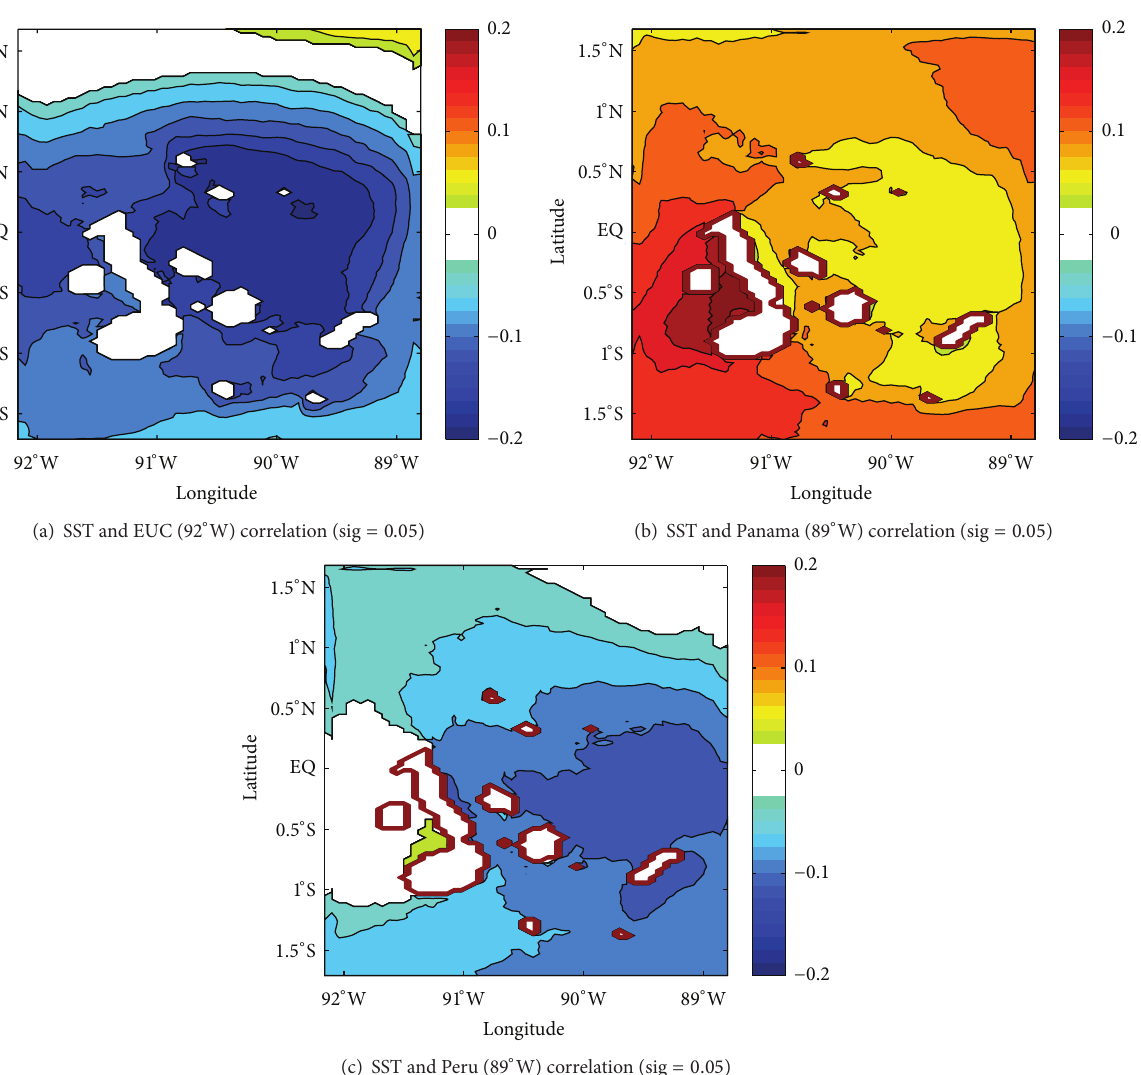
Figure 22: The contour of correlation coefficients between the simulated (a) EUC, (b) Panama current, and (c) Peru current volume flux transport under the low resolution of 0.72 ∘ × 0.36 ∘ and SST fields under the high resolution of 0.06 ∘ × 0.03 ∘ .